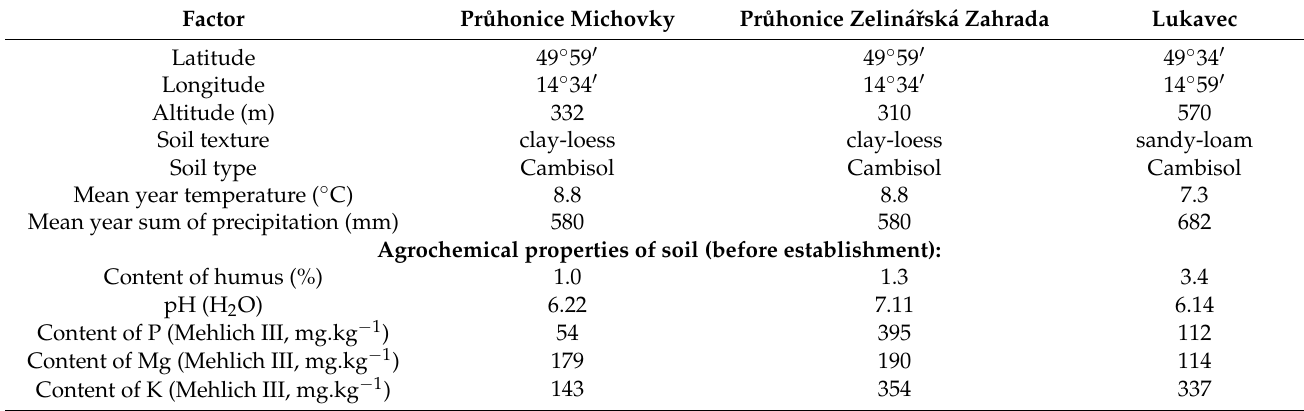
Table 1. Site conditions at locations of experiments (before planting, 2007, respectively